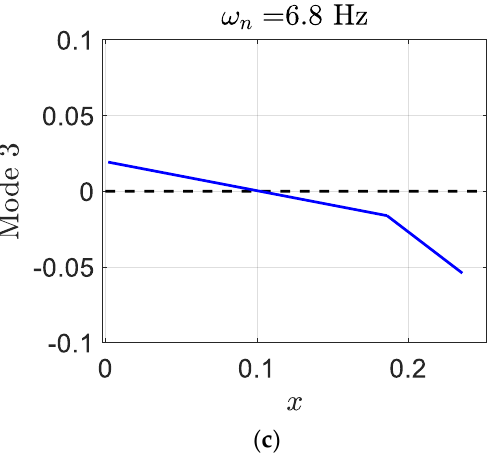
Figure 19. Mode shapes of the smart blade in unsteady plunge, pitch, and control at U = 10 m/s: ( a ) ω n = 3.5 Hz; ( b ) ω n = 2.7 Hz; ( c ) ω n = 6.8 Hz.